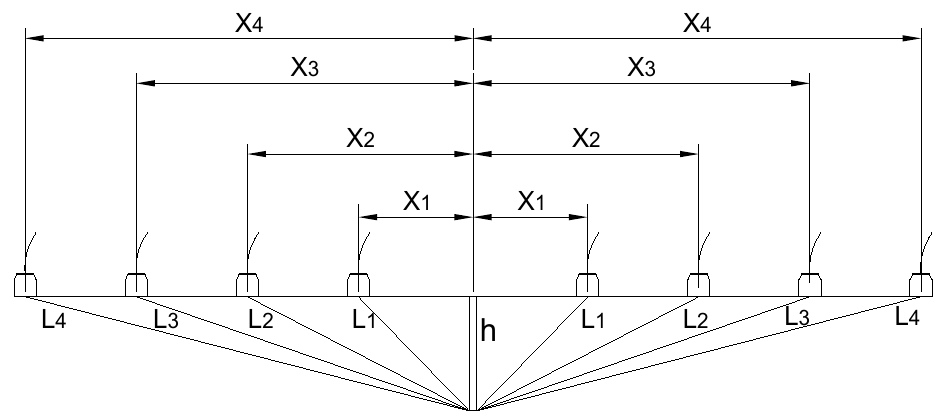
Figure 2. Transducer arrangements for graphically-based Method A